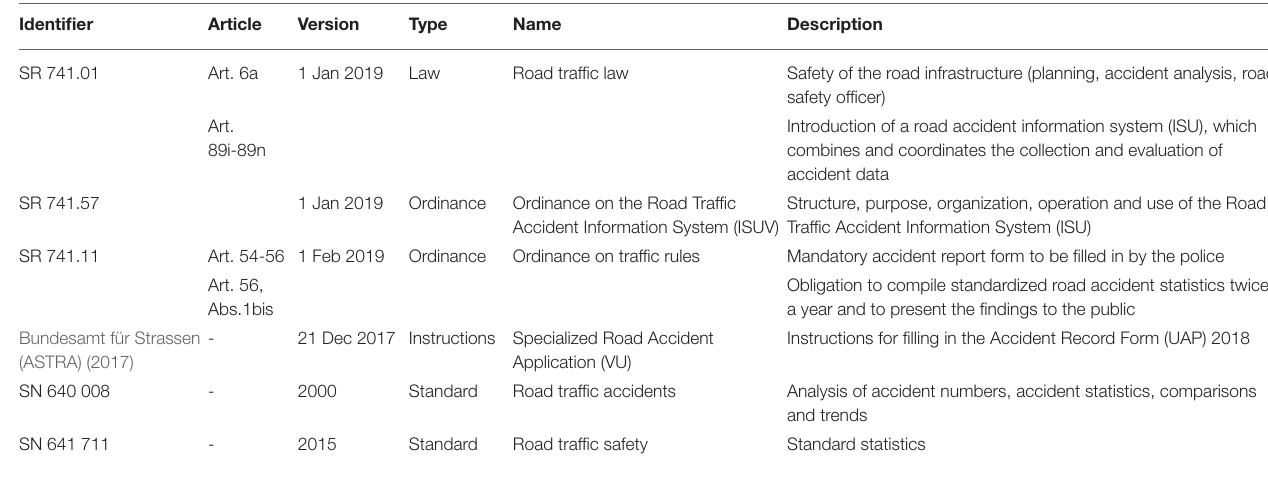
TABLE 1 | Overview of Swiss legal regulations governing road traffic accident